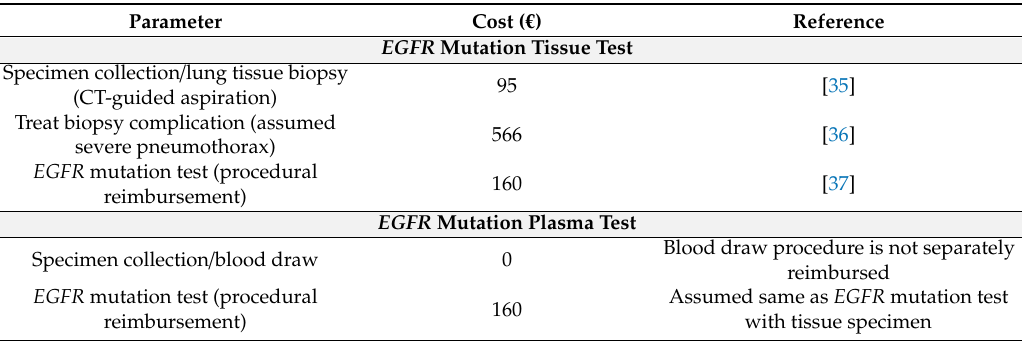
Table 3. Cost inputs used in the base-case